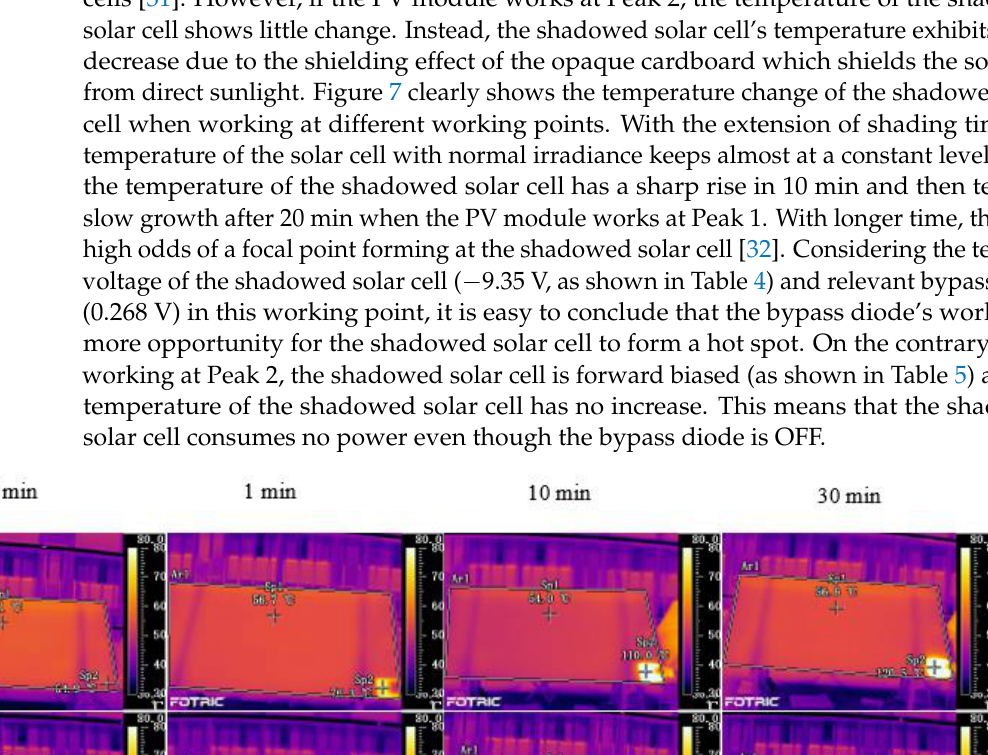
Figure 6. IR image of the PV module when working at the LMPPs (SP1 is the temperature of the solar cell with normal irradiance, SP2 is the temperature of the shadowed solar cell).